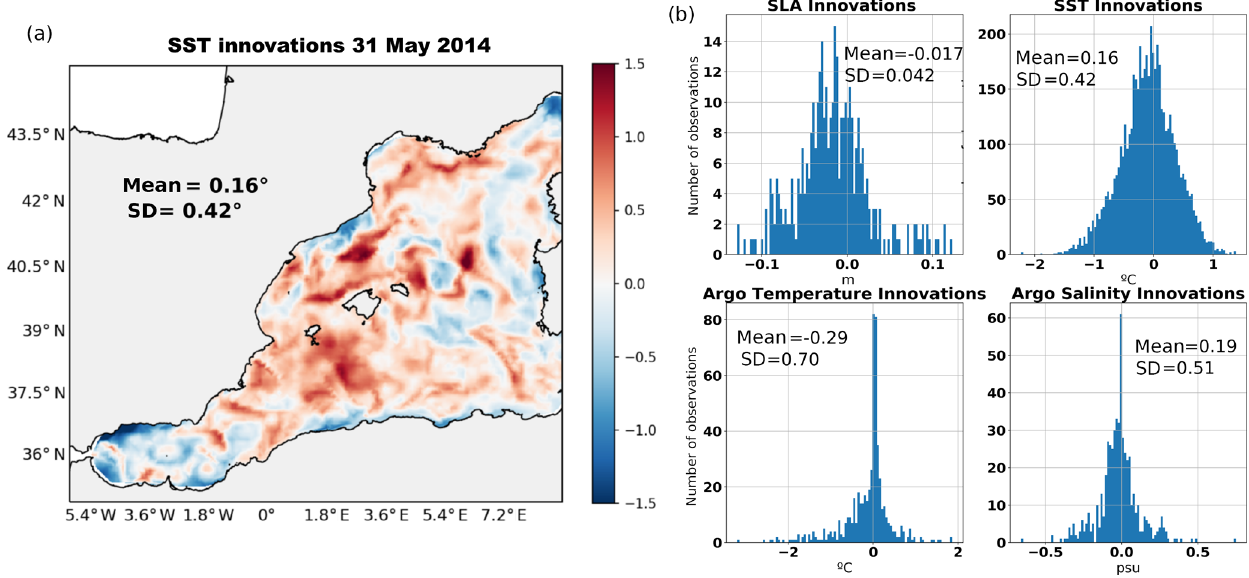
Figure 5. (a) SST misfits between the observations and the free-run model on 31 May 2014. (b) Histograms of the innovations for the different sources of observation ingested by the assimilation system. The corresponding mean and standard deviation are provided in each